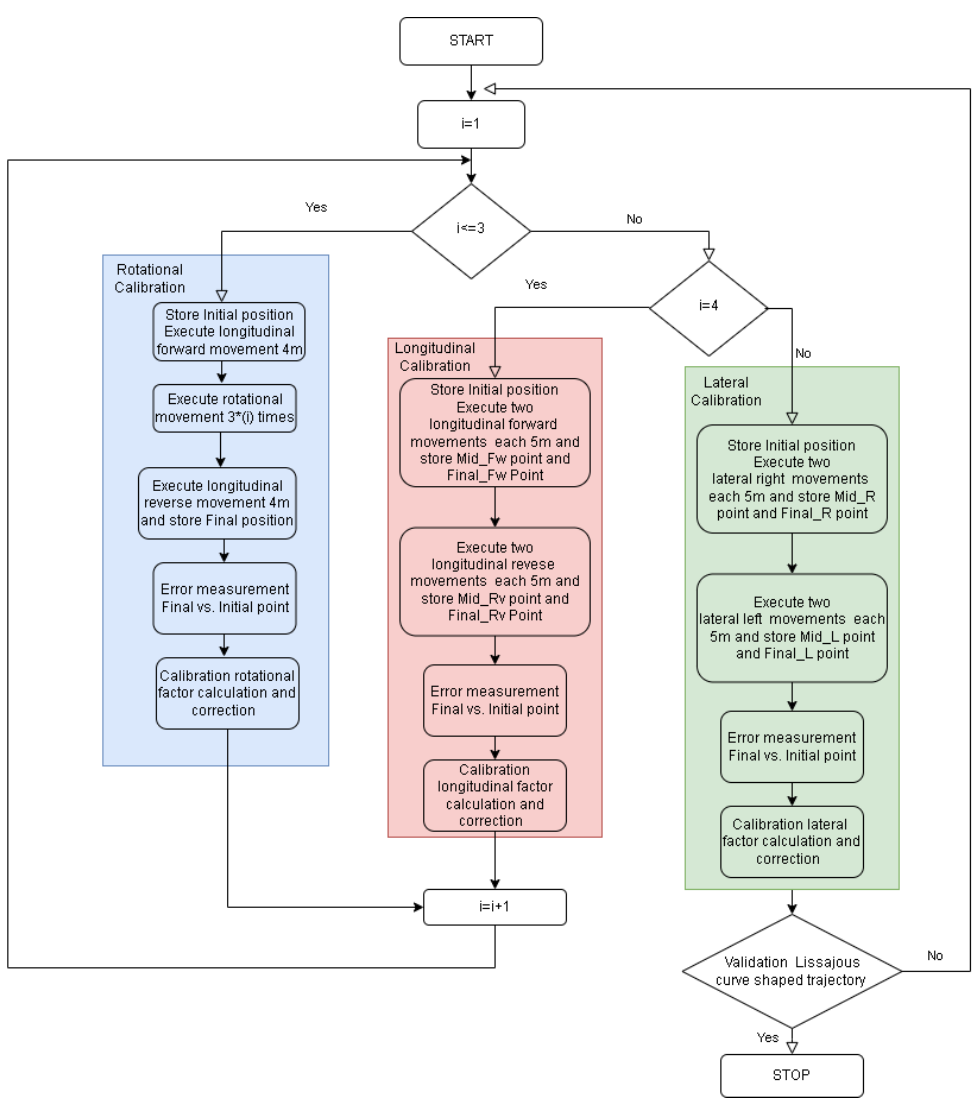
Figure 7. The flowchart of the experimental